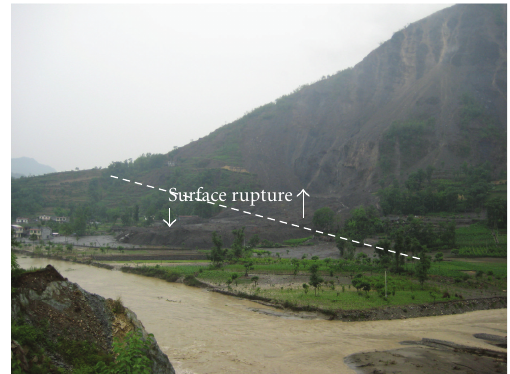
Figure 6: Secondary geologic hazards caused by fault